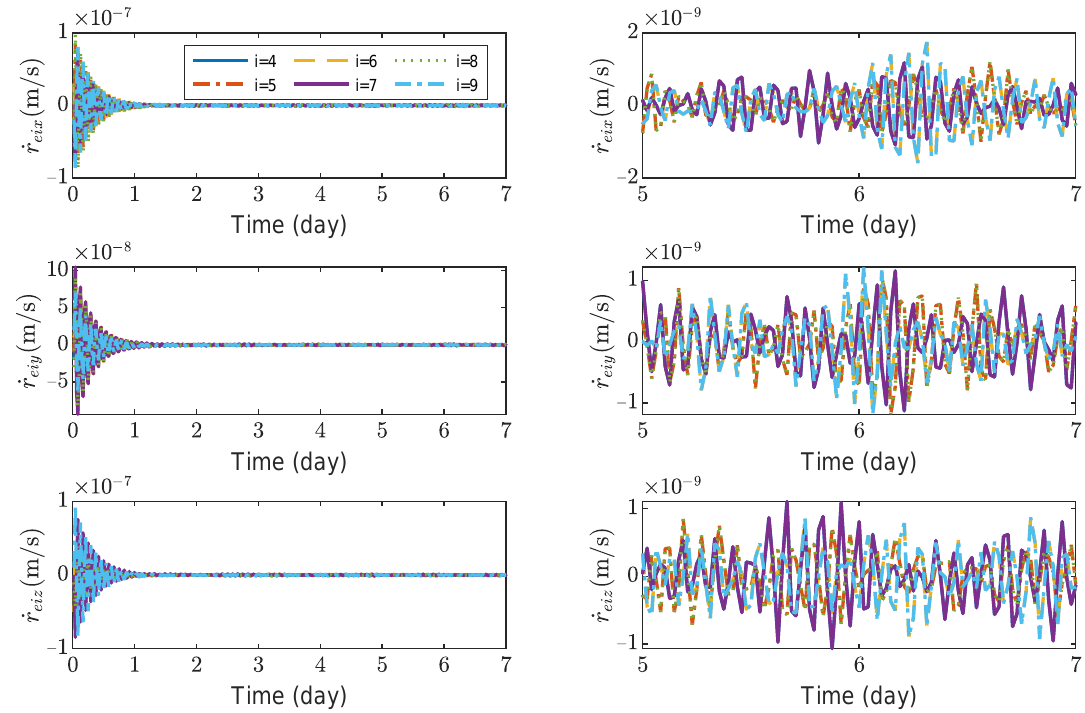
Figure 9. Relative linear velocity errors of spacecrafts TM1 ∼ 6, the max control force of spacecraft is 100 µ